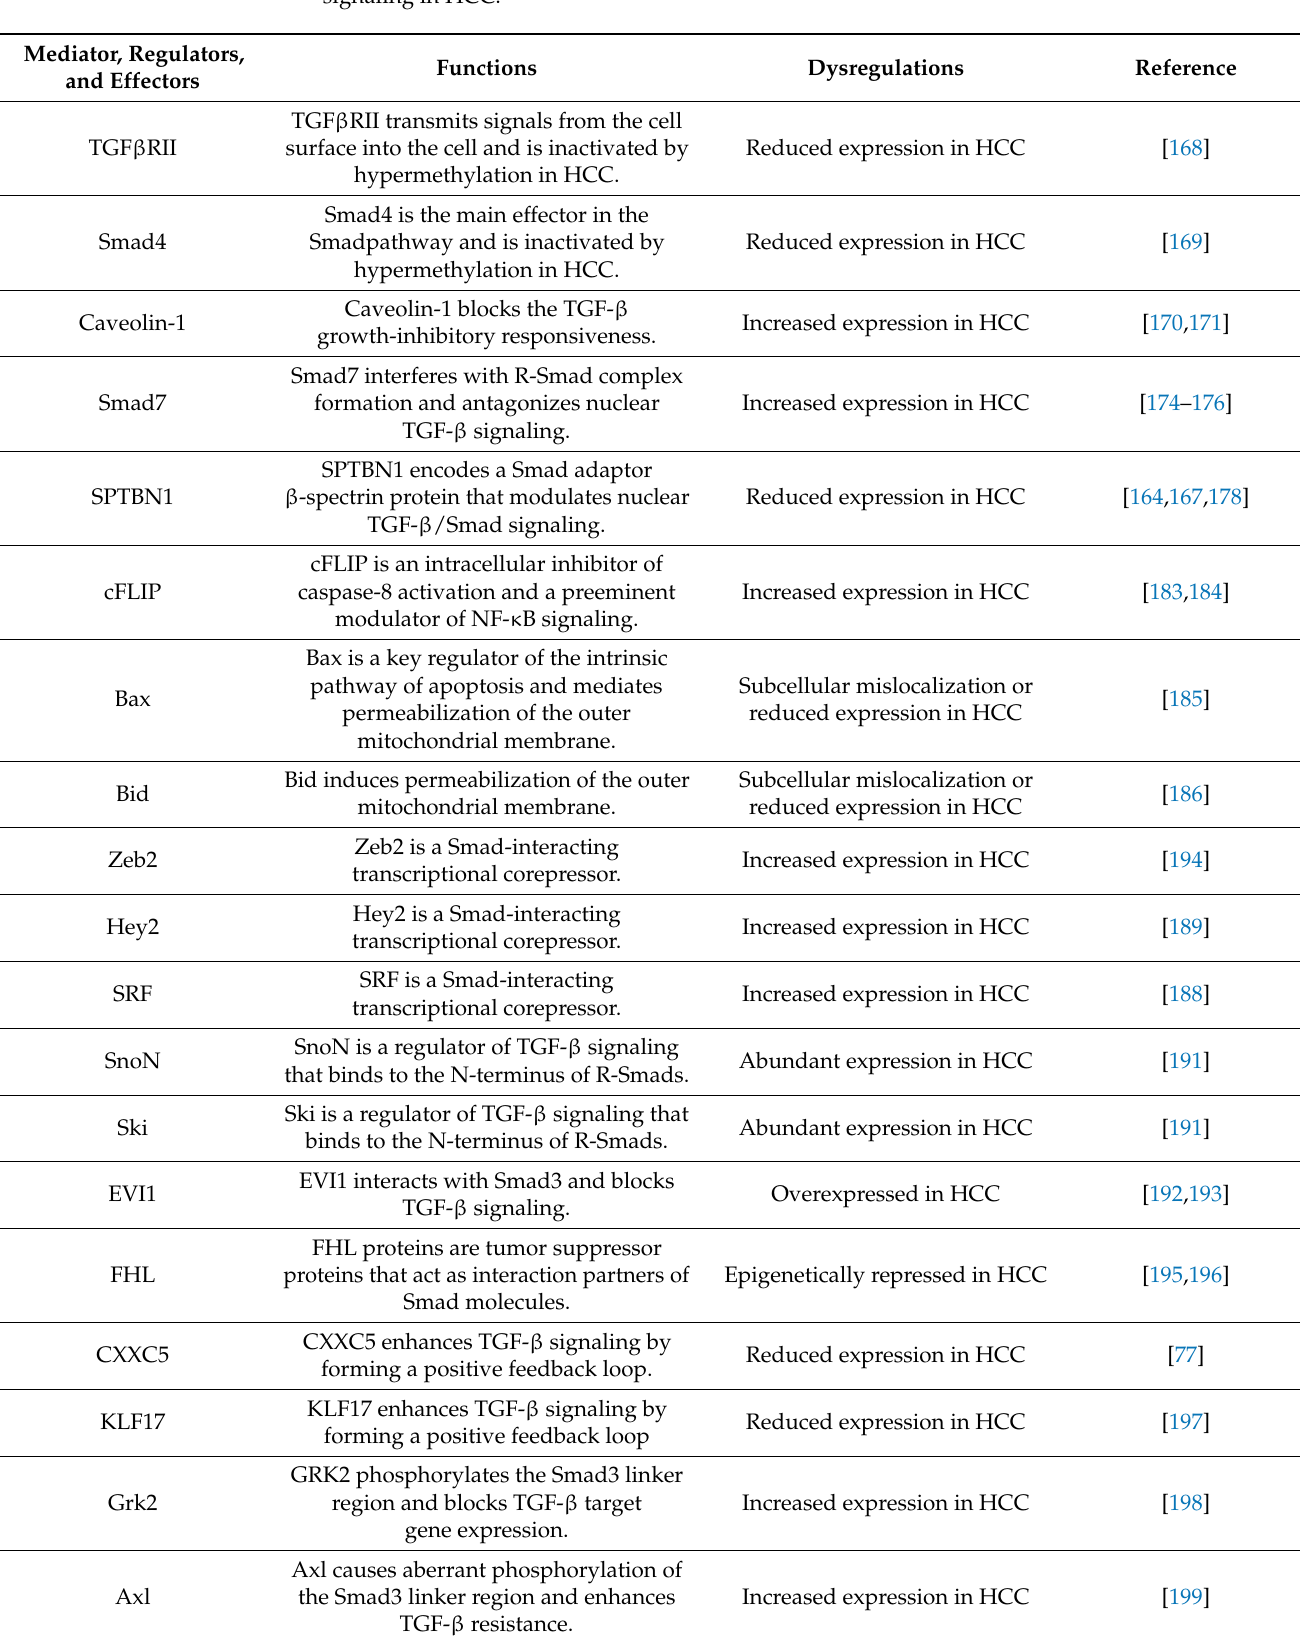
Table 2. Common dysregulation mechanisms affecting mediators, regulators, and effectors of TGF- β signaling in